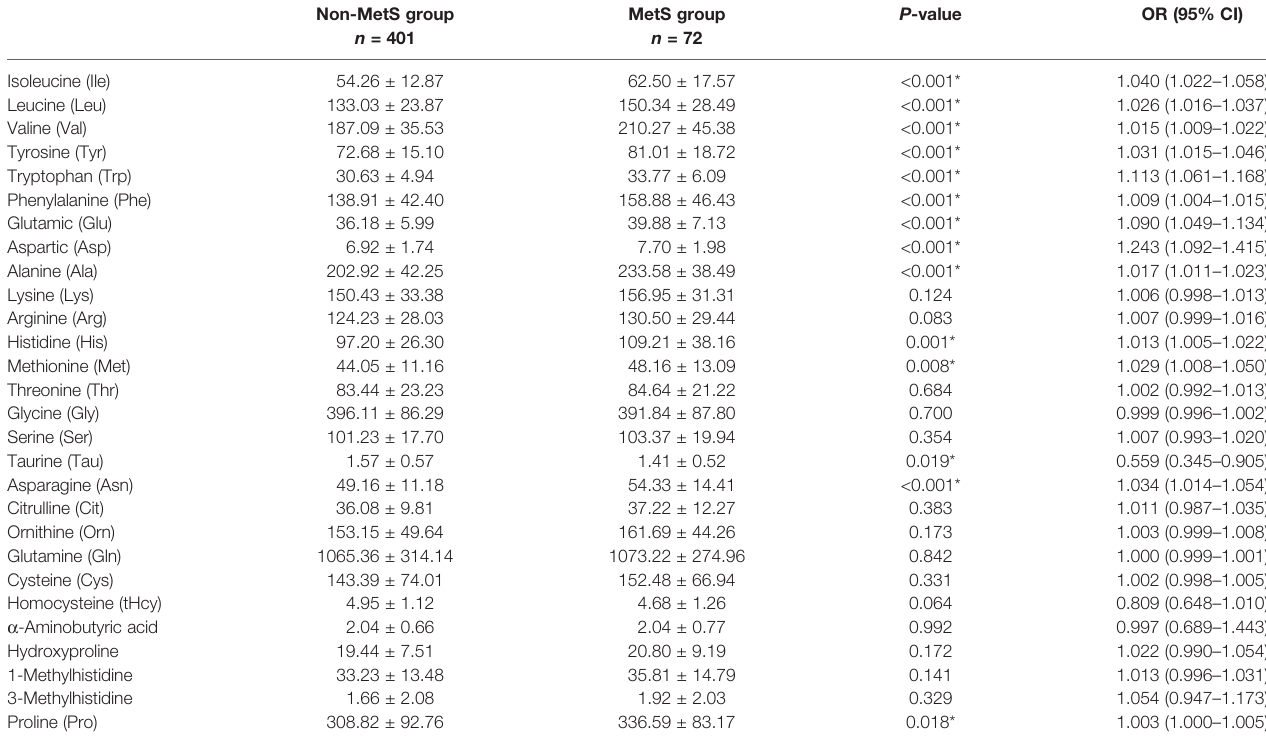
TABLE 2 | Comparison of amino acid determination results between the MetS group and non-MetS group (unit: m